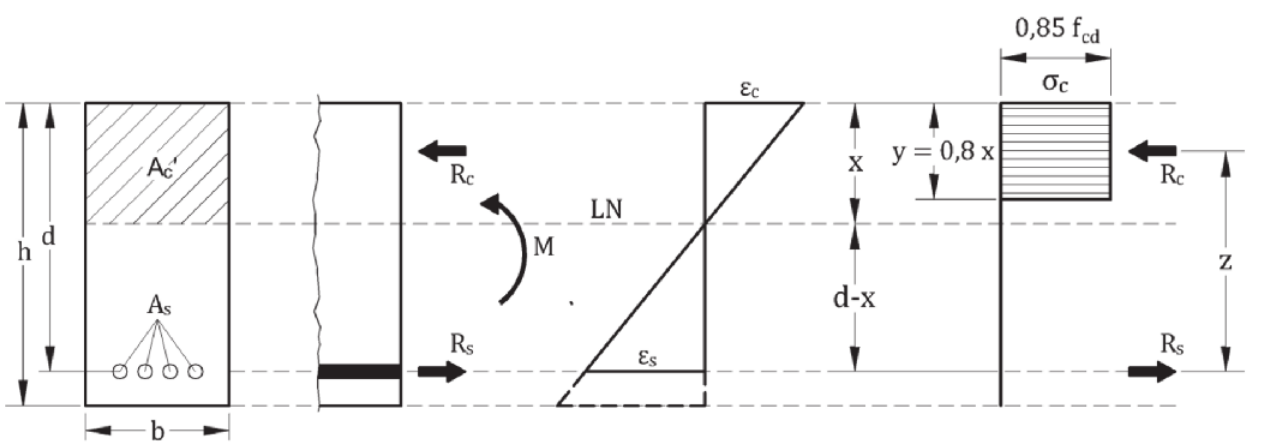
Stresses and strains in a rectangular cross-section with simple reinforcements’